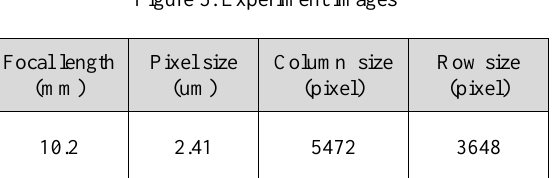
Figure 5. Experiment images